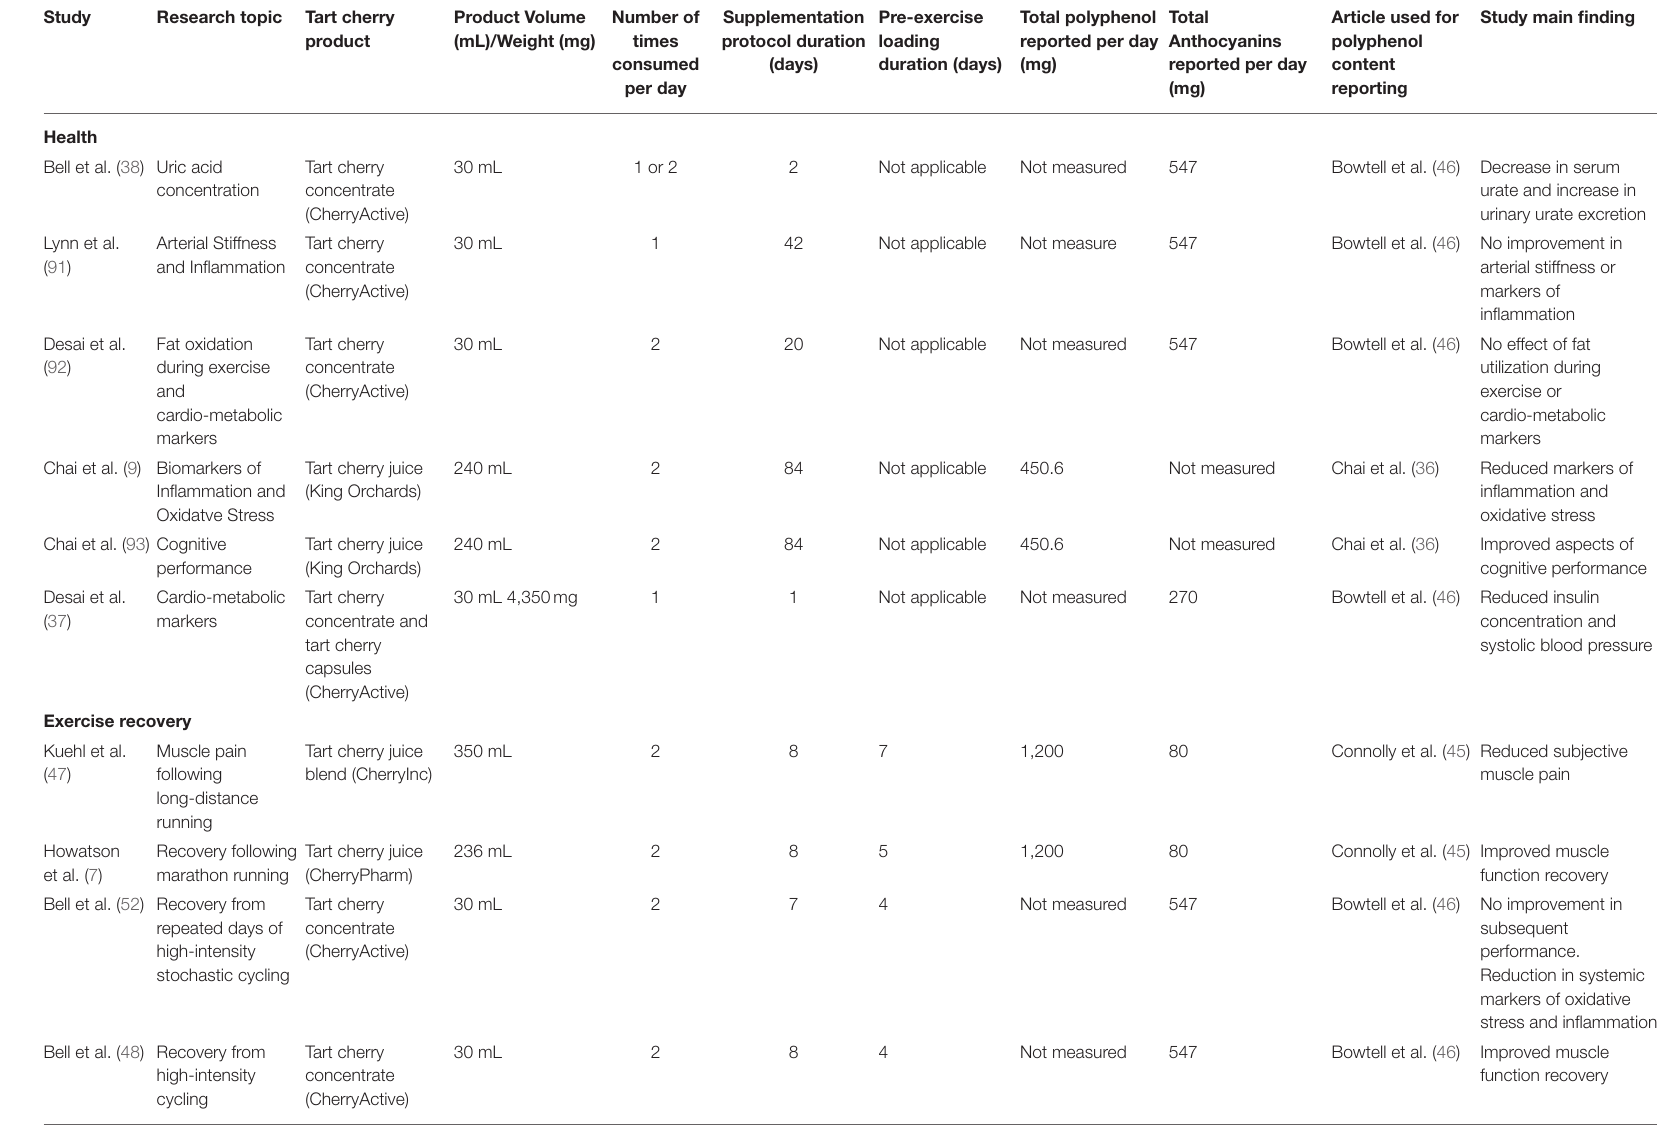
TABLE 3 | Table presenting the extracted data from the tart cherry supplementation studies included in this review that reported the characterization (polyphenol and anthocyanin content) from previously published